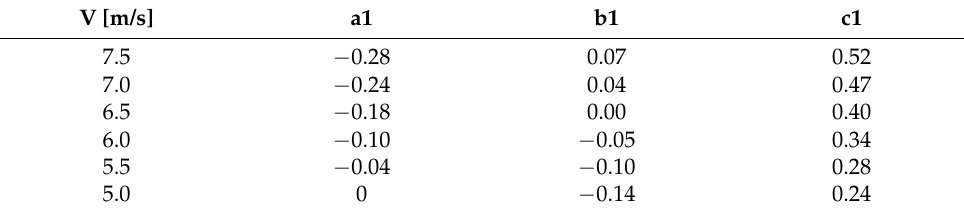
Table 1. Approximation function coefficients for single-segment rotor characteristics.